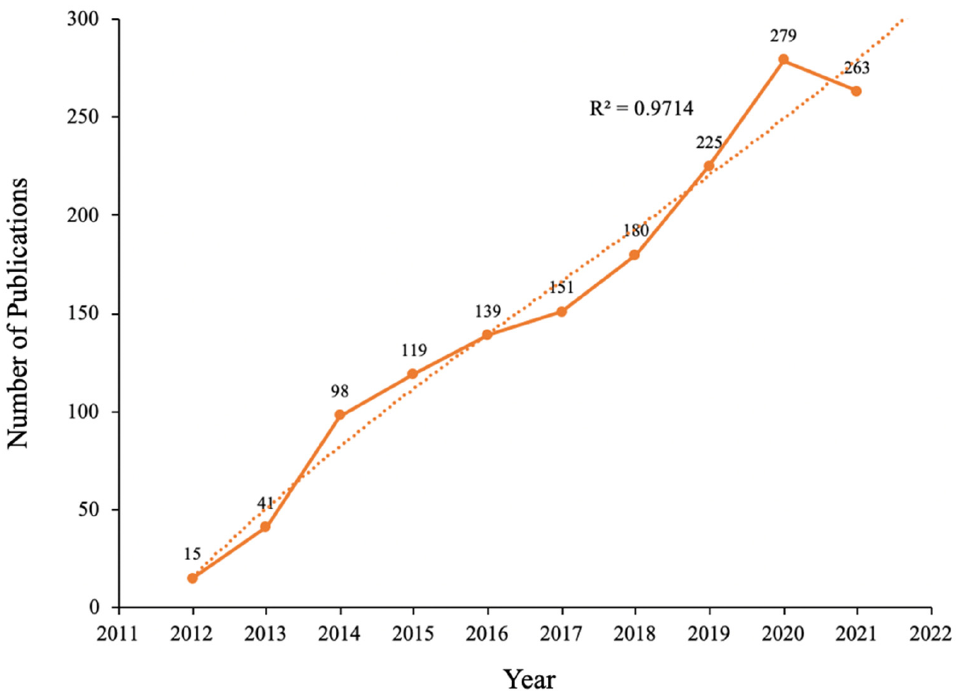
Figure 2. The number of annual publications and growth prediction of irisin research.